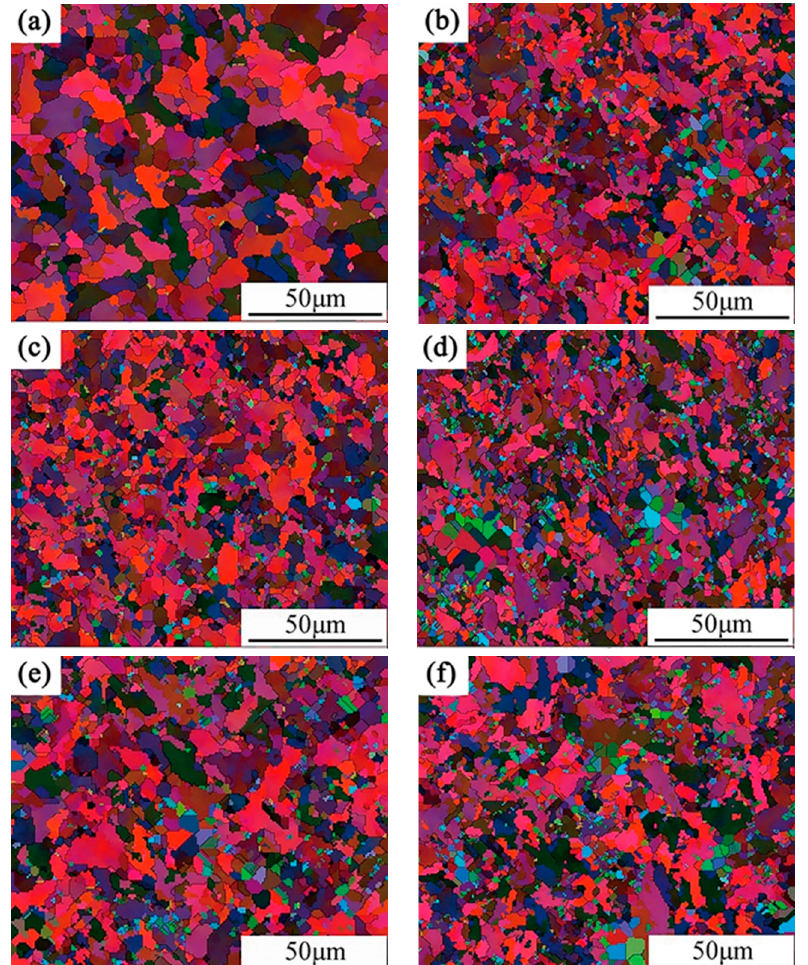
Figure 6. Electron back-scattered diffraction (EBSD) grain orientation images of surface deformation layer along axial direction of the drawn bars using ( a ), ( c ), ( e ) ECD and ( b ), ( d ) and ( f ) DIA for ( a ), ( b ) 3; ( c ), ( d ) 5; and ( e ), ( f ) 7 passes.